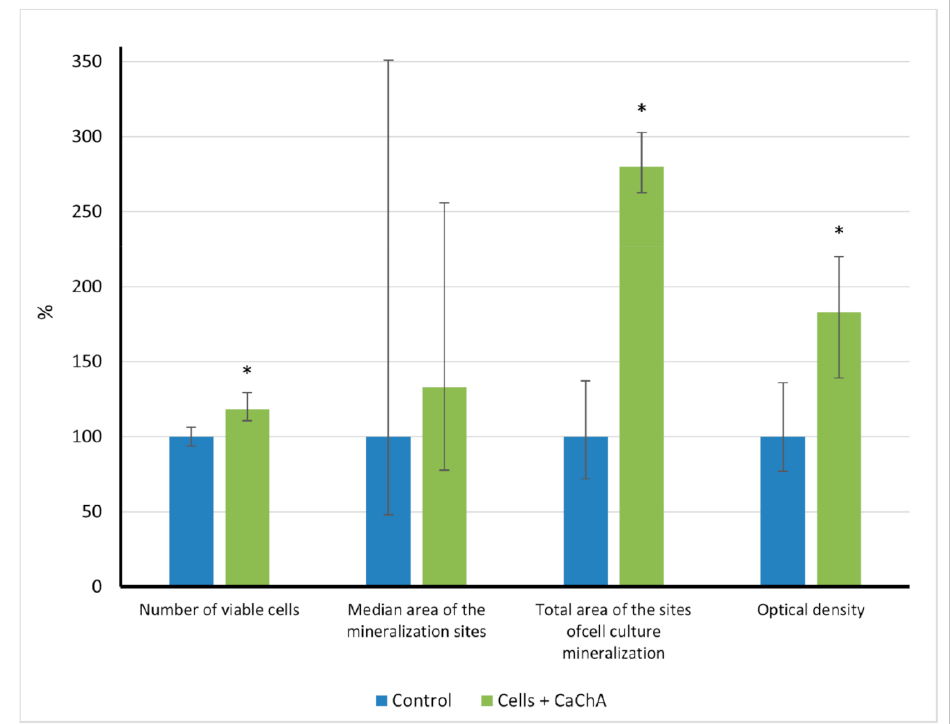
Figure 2. The in vitro indices (% of control) of human adipose-derived multipotent mesenchymal stromal/stem cells after 21 days of culture in the presence of water solvent (control) or 10 mg/L of CaChA in water solution, Me(Q1–Q3). * Statistical differences ( p < 0.05) with the control according